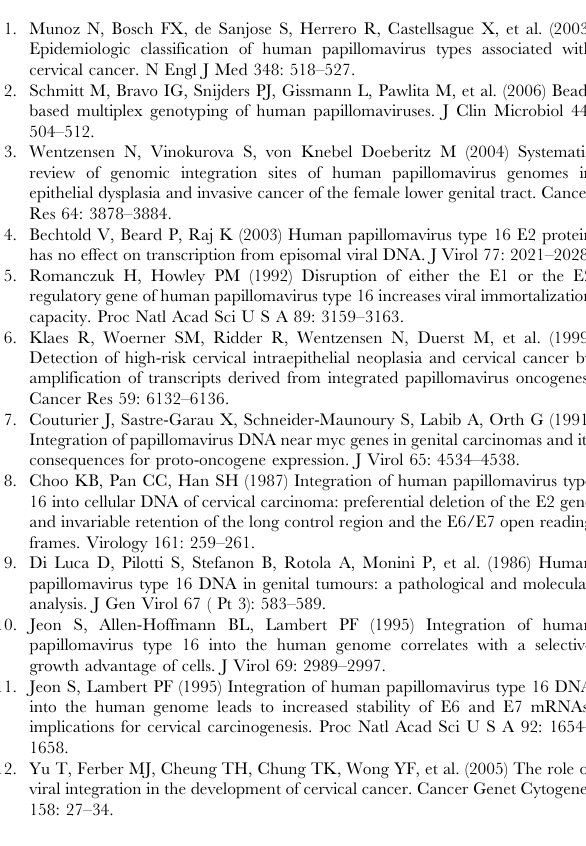
Figure S1 Kaplan-Meier analysis for two HR-HPV types – HPV16 and/or HPV18 and disease outcome. Kaplan- Meier survival analysis for HPV16 and/or HPV18 in 125 patients who had a good clinical follow up was carried out. Patients with HPV16 infection alone showed a trend towards better disease free survival as compared to HPV18 infection alone and dual infection with HPV16/18. Figure S2 Genomic DNA PCR of the recurrent integra- tion sites. Representative gel images (a, b) showing HPV integration at the genomic level. Recurrent integrations at